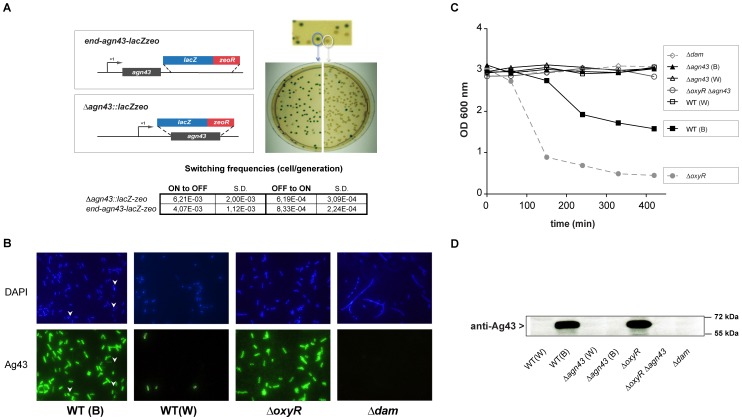
Construction and characterization of agn43-lacZ transcriptional fusions.
A. Schematic representation of TG agn43-lacZ and TG Δagn43::lacZ fusions (not to scale). Blue or white colony plated on LB agar+X-gal plates: a blue colony gives rise to blues and whites and vice versa. Switching frequencies (ON or OFF cells/generation) of the transcriptional fusions were calculated as described in the materials and methods. S.D.: standard deviation. B. DAPI and immunofluorescence microscopy of a TG agn43-lacZ blue (ON) colony and a white (OFF) colony. Anti-Ag43 polyclonal antibody was used to detect surface-exposed Ag43. WT(B): wild-type ON colony with OFF cells pointed out by white arrow heads, WT(W): wild-type OFF colony, ΔoxyR: agn43 locked-ON strain, Δdam: agn43 locked-OFF strain. C. Kinetics of aggregation of overnight cultures inoculated with TG agn43-lacZ (WT) and Δagn43::lacZ strains (Δagn43) blue or white colony. D. Immunodetection of Ag43 in TG agn43-lacZ and Δagn43::lacZ cultures started with either an ON or OFF colony, using an anti-Ag43 polyclonal antibody. In a TG agn43-lacZ background, WT(W): OFF colony, WT(B): ON colony, ΔoxyR: locked-ON strain, Δdam: locked-OFF strain. In TG Δagn43::lacZ background, Δagn43 (W): OFF colony, Δagn43 (B): ON colony, ΔoxyRΔagn43: locked-ON strain.